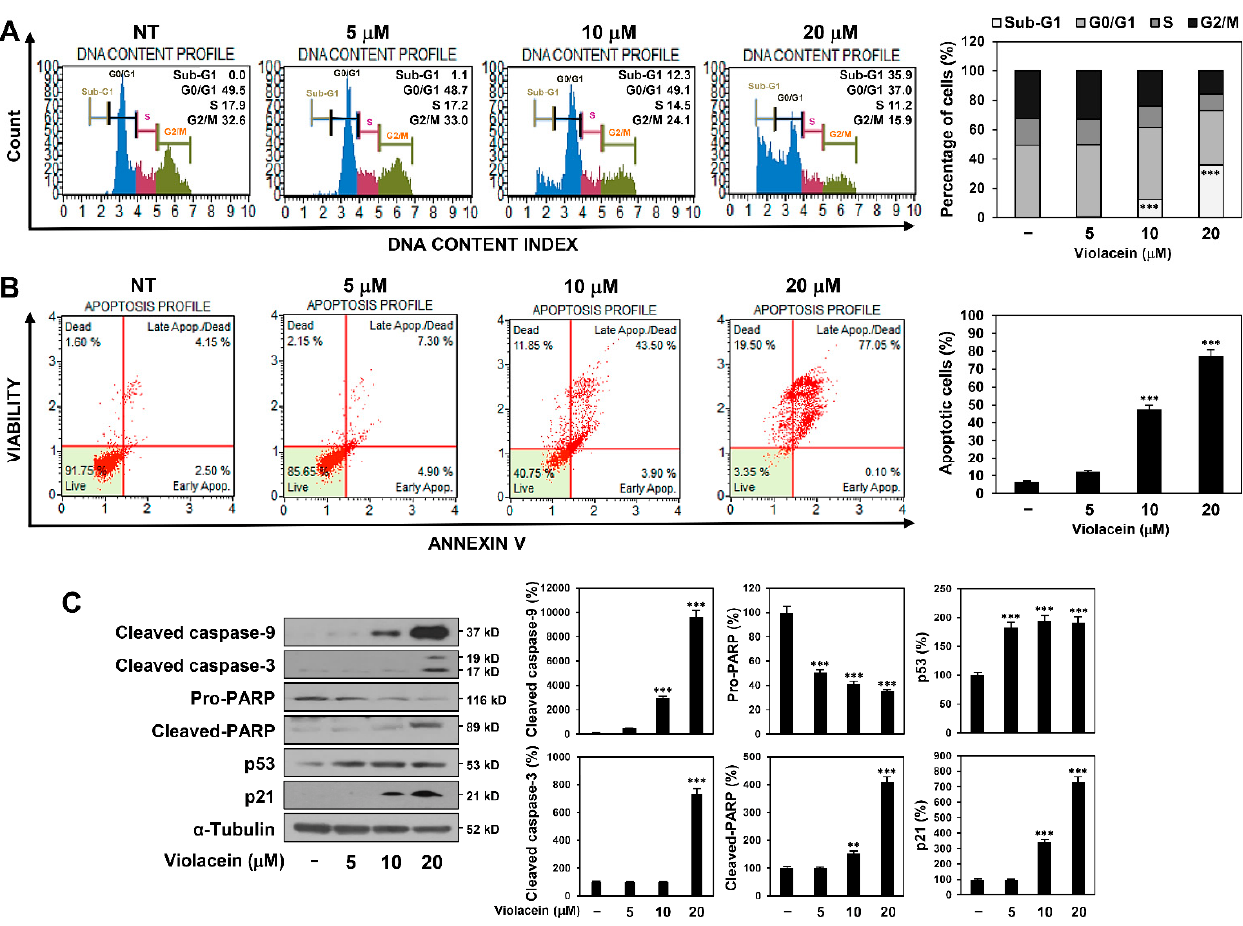
Figure 3. Violacein induces cell cycle arrest at the sub-G1 phase and cellular apoptosis in Huh7 HCC cells. ( A − C ) Huh7 cells were treated with violacein (5, 10, and 20 µM) for 24 h. ( A ) Effect of violacein on the cell cycle. The cell cycle distribution was evaluated using a Muse Cell Analyzer with Muse ® Cell Cycle kit. ( B ) Effect of violacein on the apoptotic cell death. Apoptotic cells were detected using a Muse Cell Analyzer with Muse ® Annexin V & Dead Cell kit. ( C ) Effect of violacein on the expression of apoptosis regulators. Protein levels were detected by Western blot analysis using specific antibodies and were further quantified by densitometry. α –tubulin levels were used as an internal control. ∗∗ p < 0.01, ∗∗∗ p < 0.001 vs. the control.